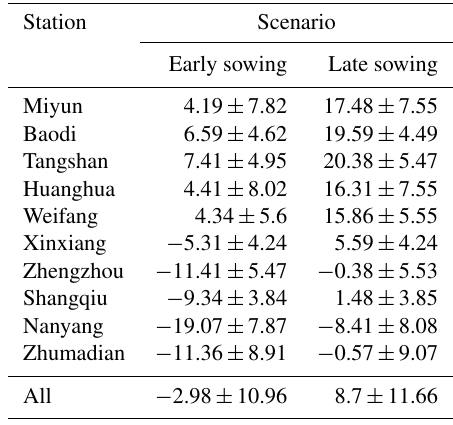
Table 5. The difference between simulated and observed sowing dates under two scenarios at each